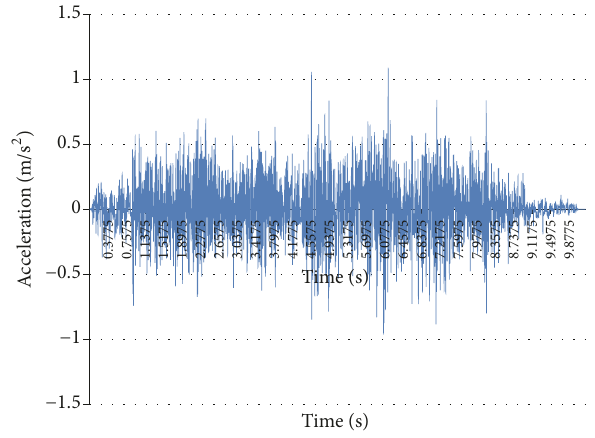
Figure 3: Acceleration time histogram.